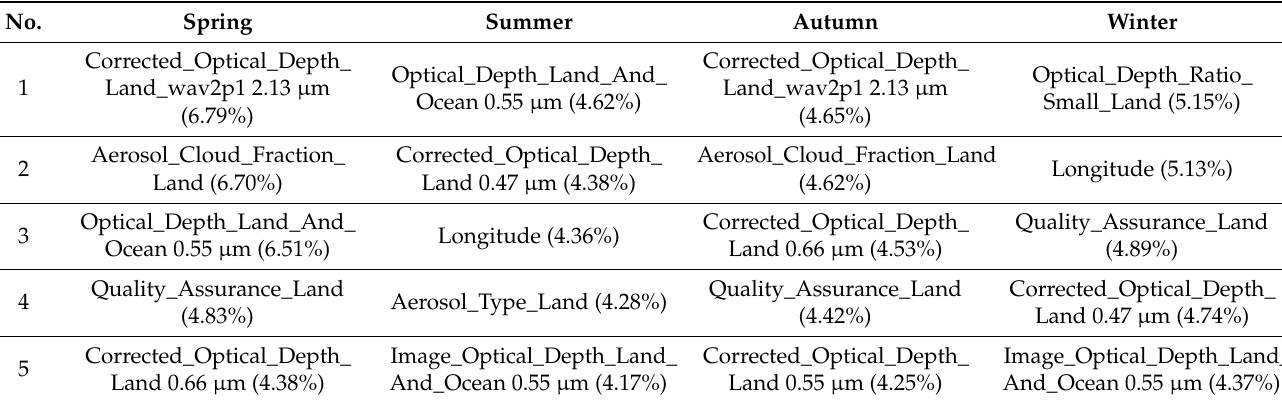
Table 1. The most influential variable per season.